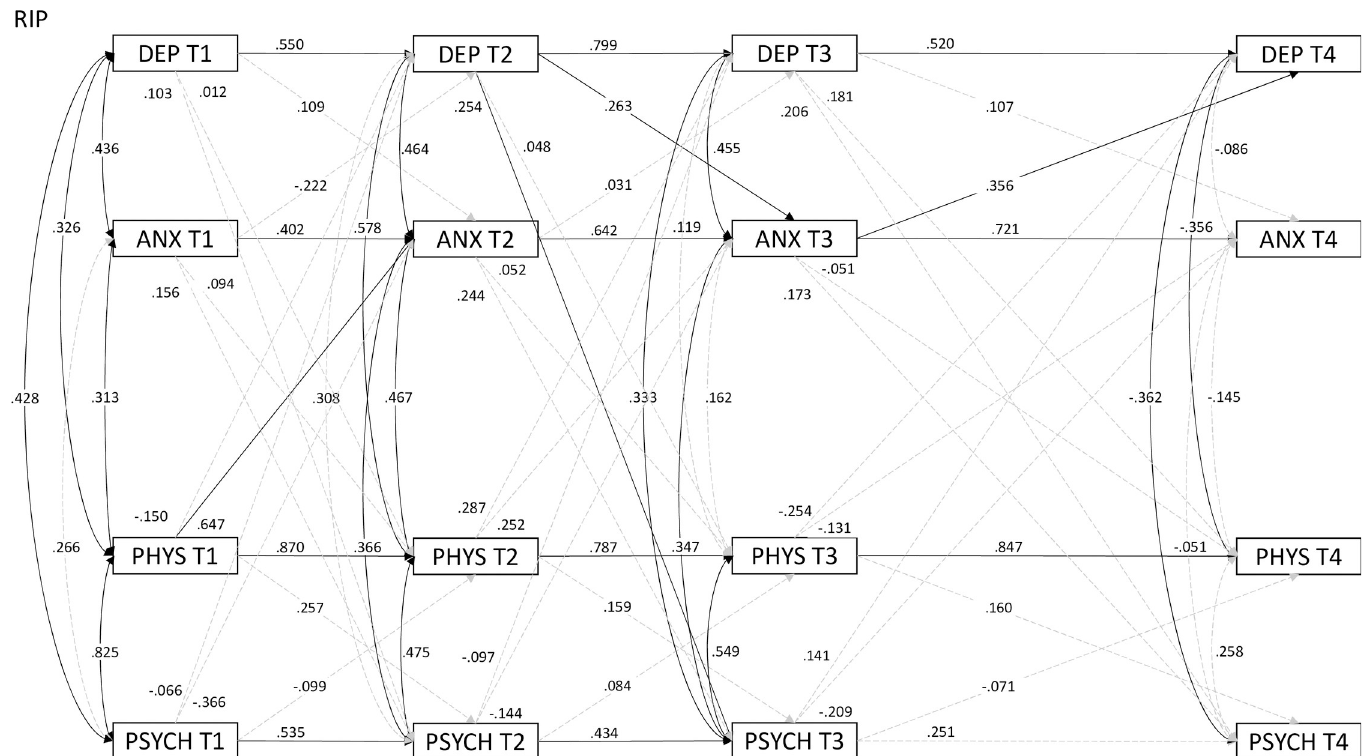
Fig 3. Cross-lagged panel model of MSIS-29 and HADS over four timepoints for RIP ( n = 33). Note : Solid arrows are p < .05; dashed arrows are nonsignificant; numbers above arrows indicate standardized coefficients.